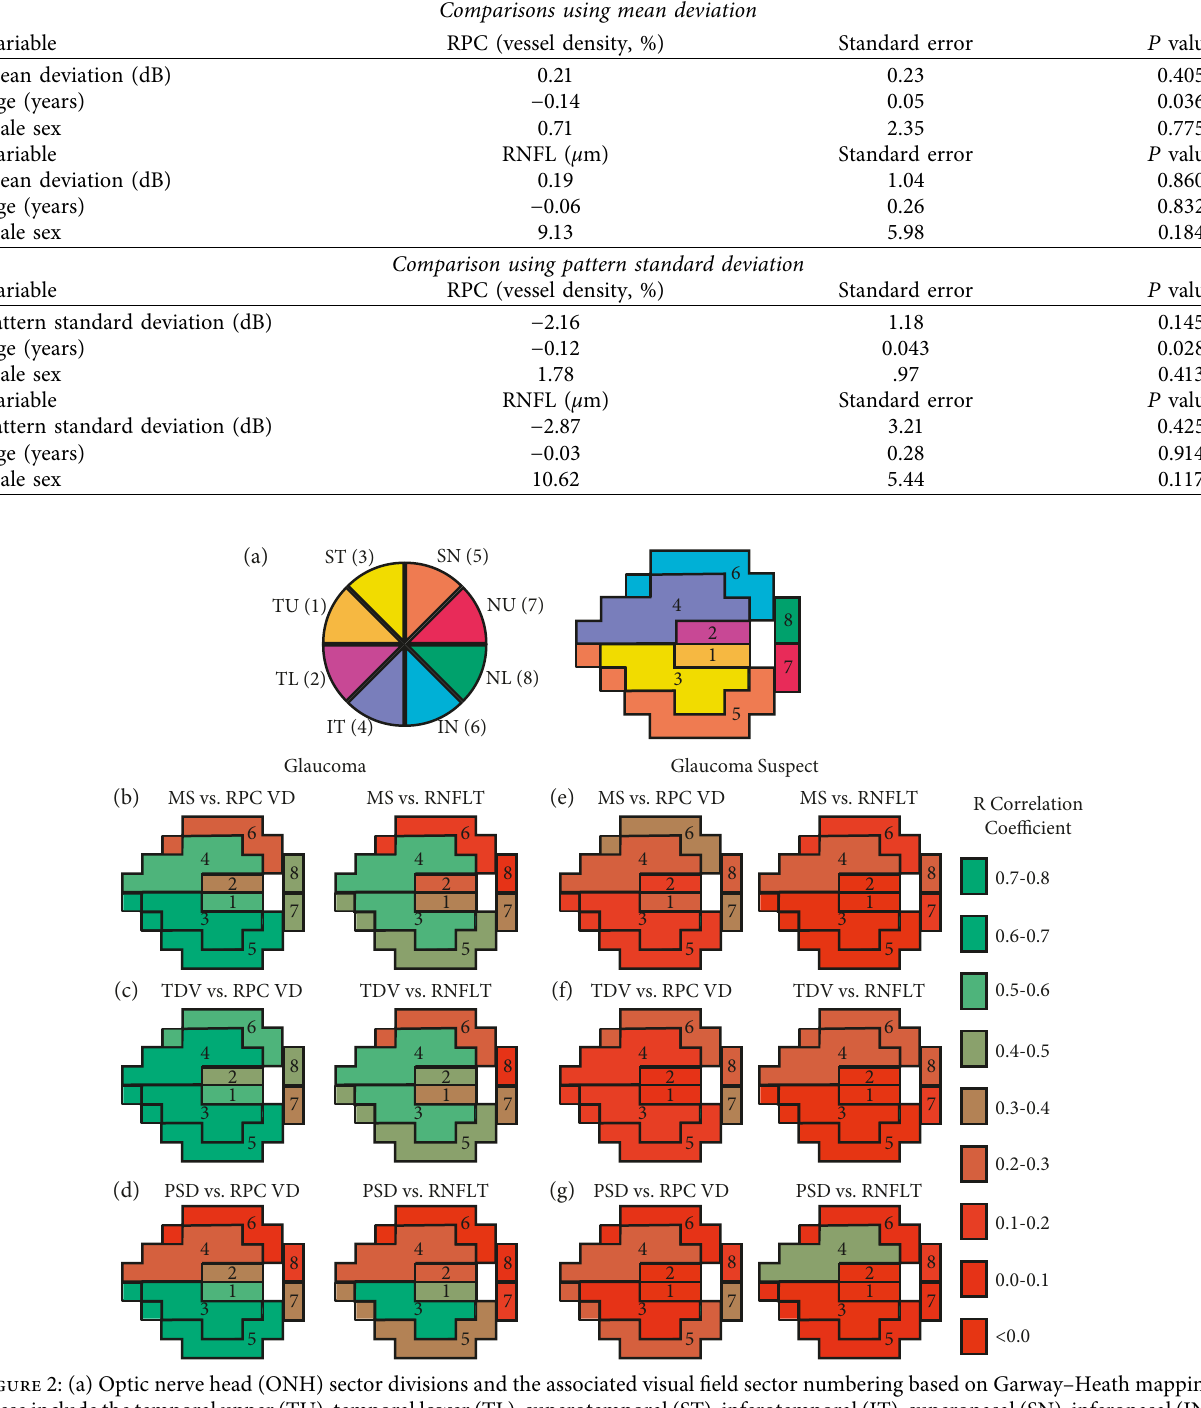
Table 3: Linear regression model with robust standard errors of visual and structural parameters adjusted for age and sex in glaucoma suspect subjects.